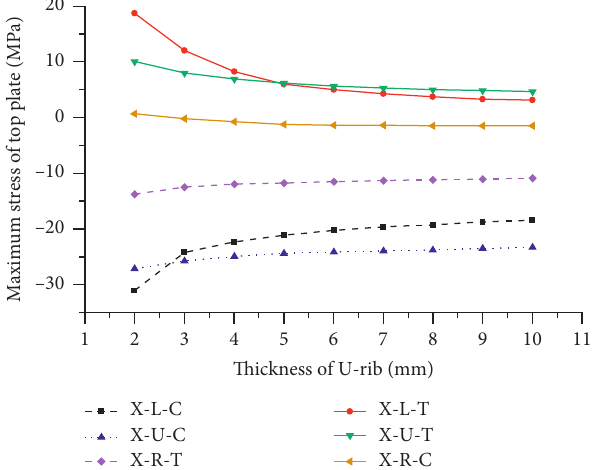
Figure 18: Influence of the change of U-rib thickness on the maximum stress in X direction of the top